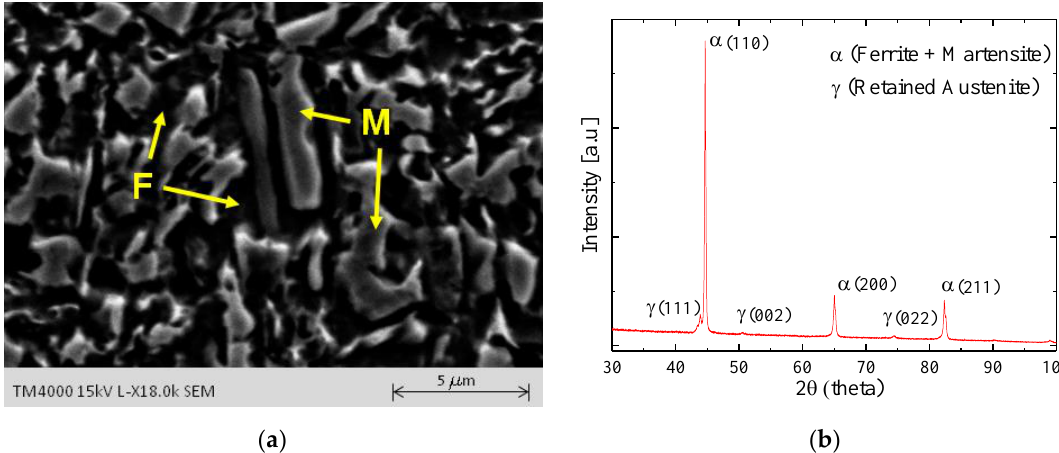
Figure 10. ( a ) SEM micrograph of base metal and ( b ) intensity vs. 2° theta for the base metal—XRD spectrum analyze.